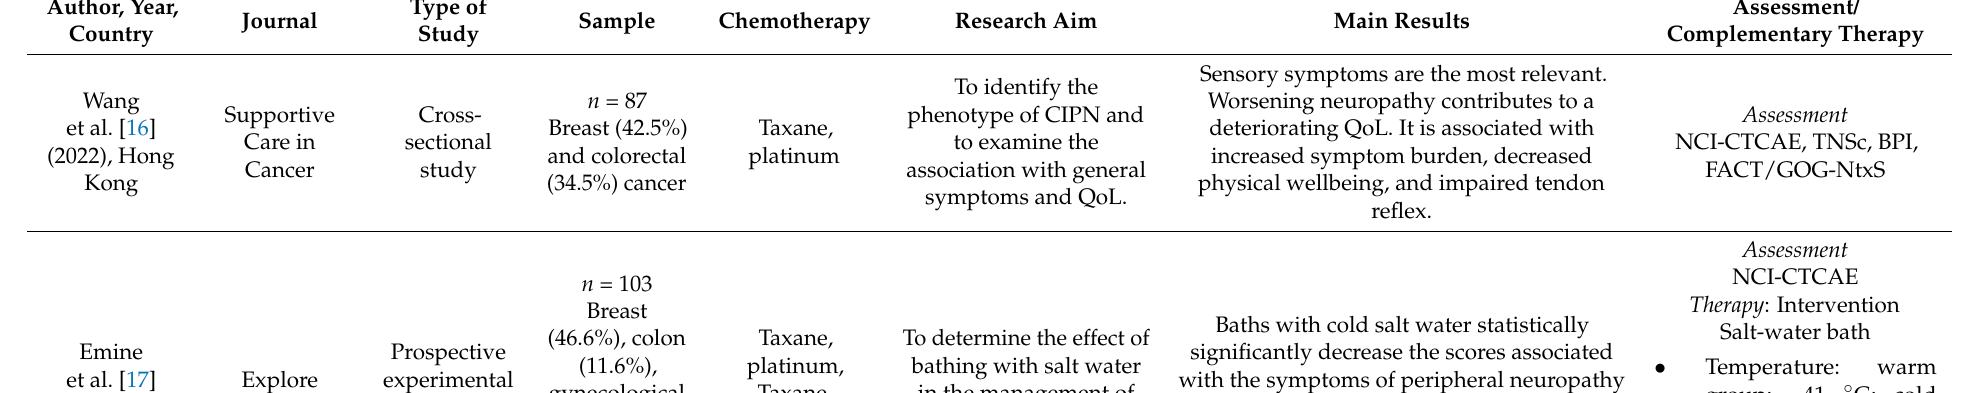
Table 2. Quality of life, assessment, and complementary therapies for CIPN in people with breast